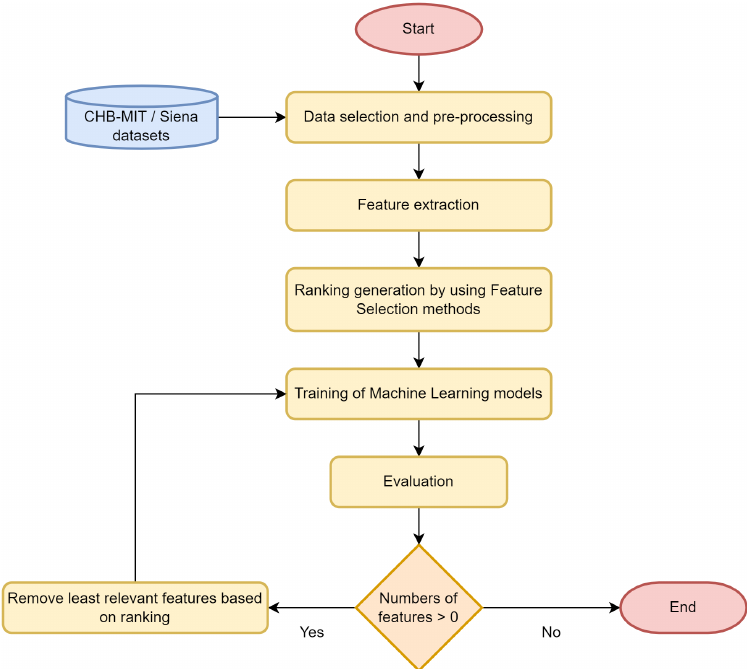
Figure 1. Flow diagram of the